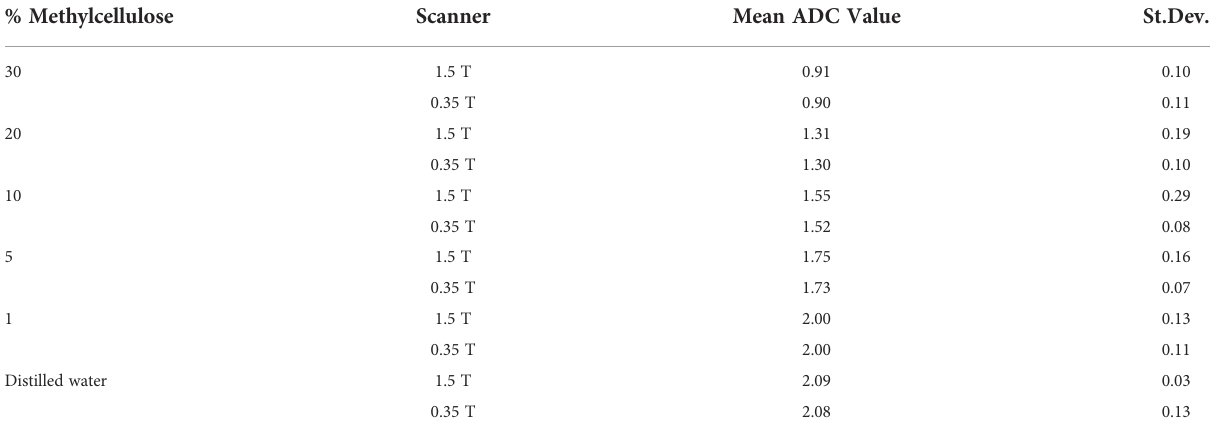
TABLE 6 Mean values of ADC (10 − 3 mm 2 /s) obtained for different methylcellulose concentrations and distilled water. % Methylcellulose Scanner Mean ADC Value St.Dev.